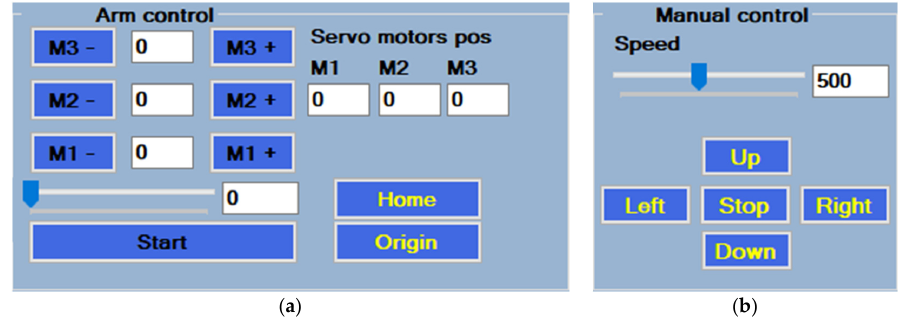
Figure 6. Robotic arm in laboratory-stage development: ( a ) CAD version; ( b ) practical test version.